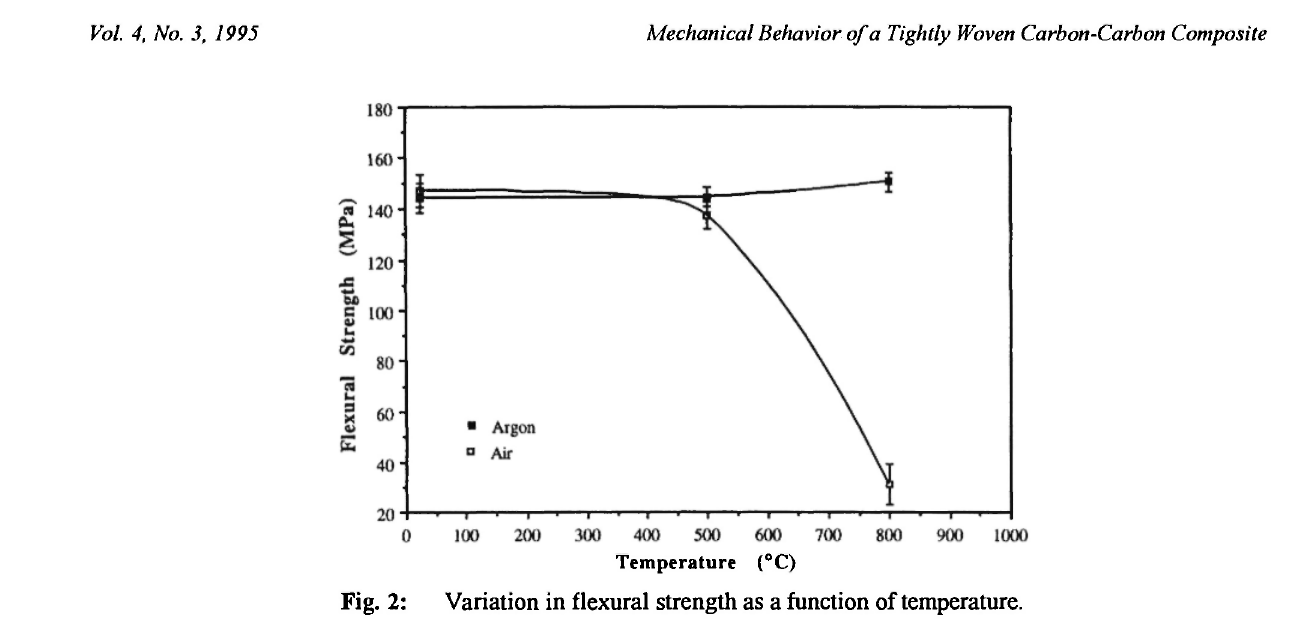
Fig. 2: Variation in flexural strength as a function of